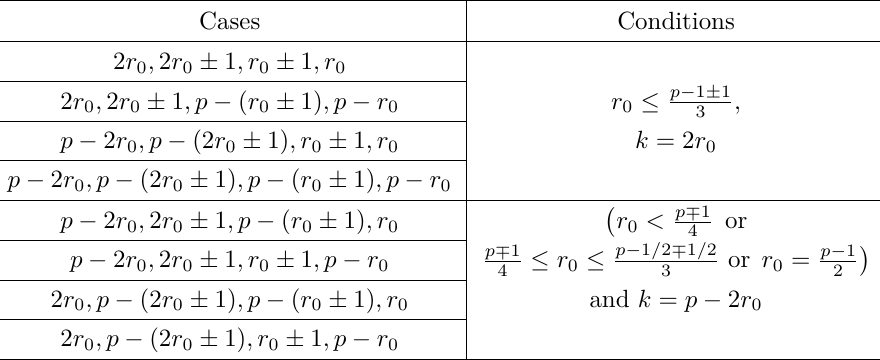
Table 12. One set of possible CBs in minimal models that Γ 0 (4) ∩ Γ(2) corresponds to. There are similar relations for s 0 by a simple substitution of the corresponding letters, where we have set 0 , l, p . α 4 = α r 0 ,s 0